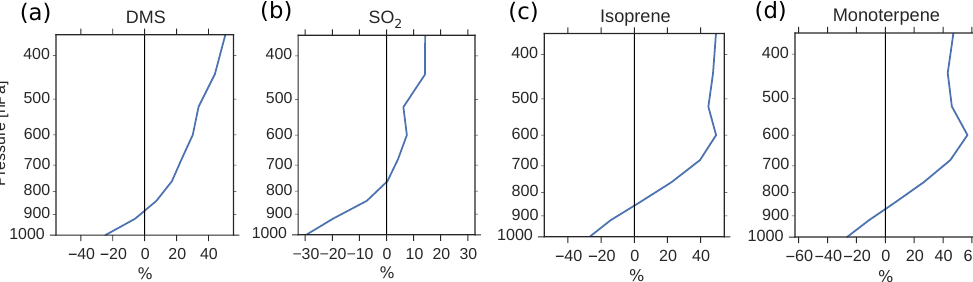
Figure 5. Global mean relative change in chemical loss of (a) DMS, (b) SO 2 , (c) isoprene and (d) monoterpene when switching from PD to PI oxidants in the PI simulation.